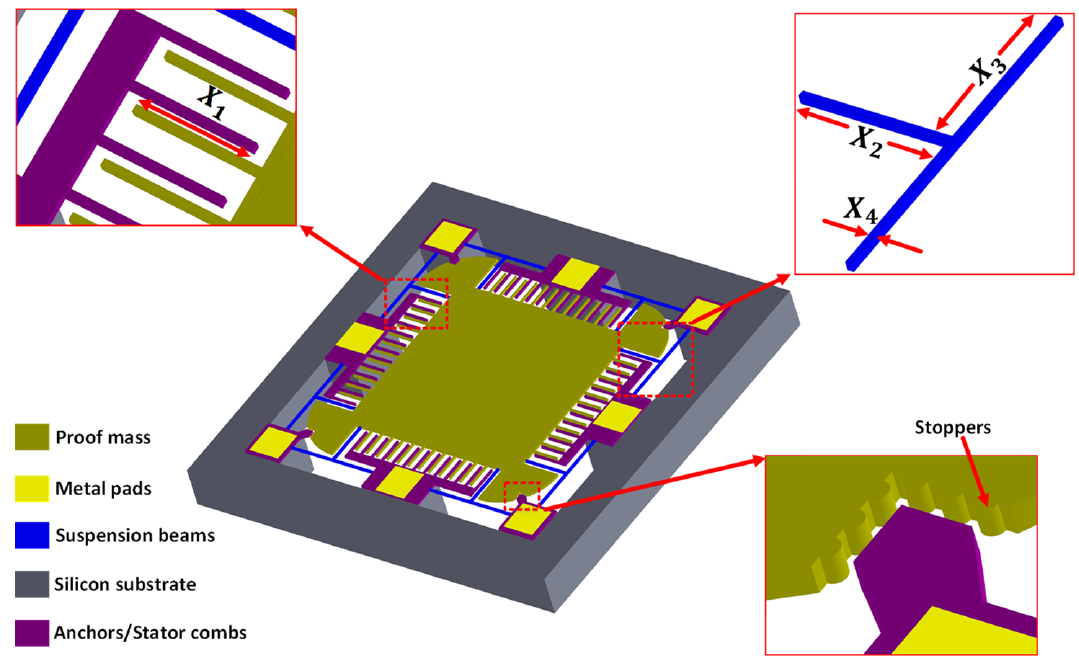
Figure 1. The 2-DoF MEMS capacitive MEMS accelerometer design [17].